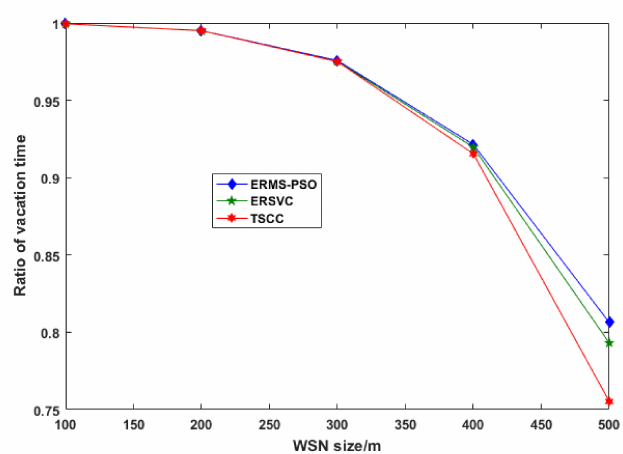
Figure 7. Ratio of vacation